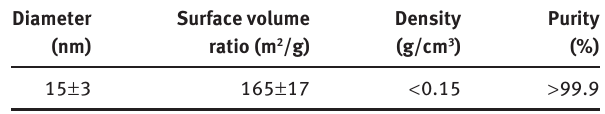
Table 2 Properties of